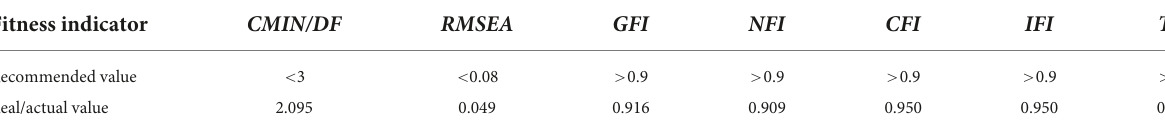
TABLE 5 Results of model fitness.